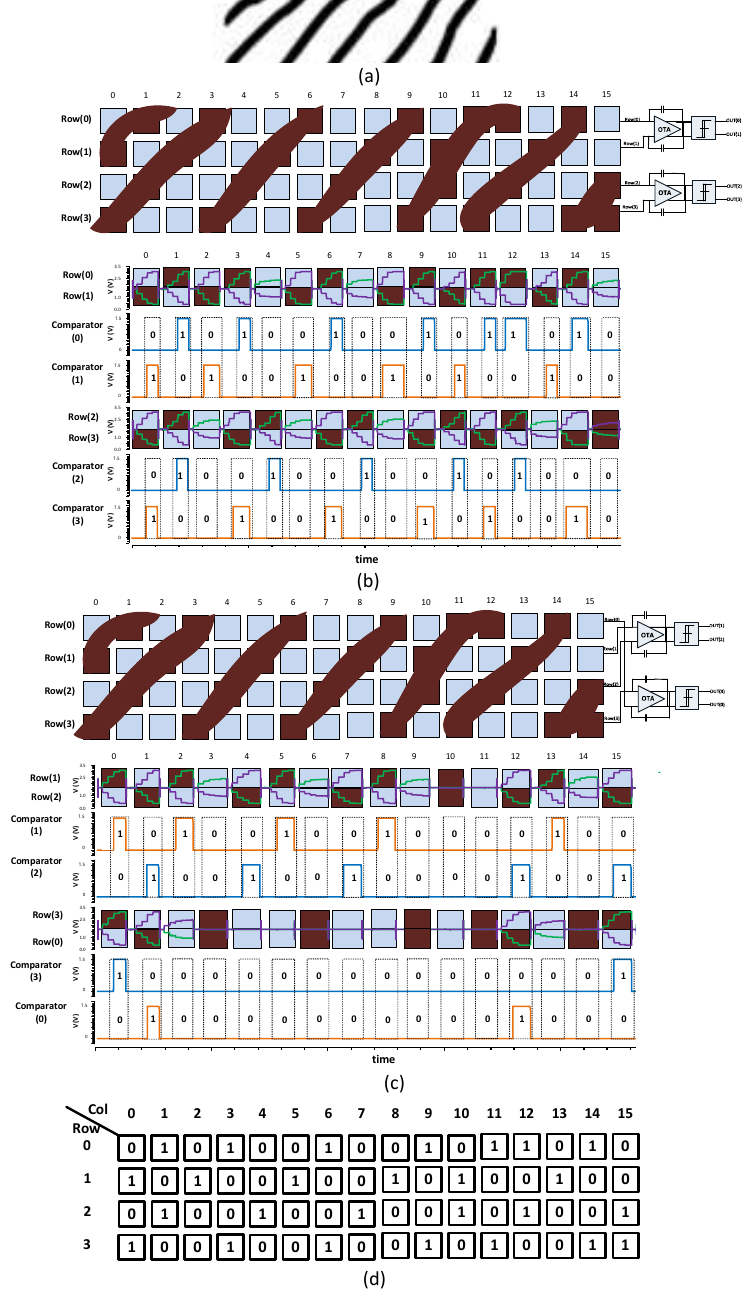
Figure 7. Proposed method to enhance the detection of finger features based on differential readout circuit. ( a ) A sample of finger features; ( b ) reading the modeled sample of finger features in phase 1 and its comparator output; ( c ) reading the modeled sample of finger features in phase 2 and its comparator output; ( d ) the final image output after comparing the two frames.